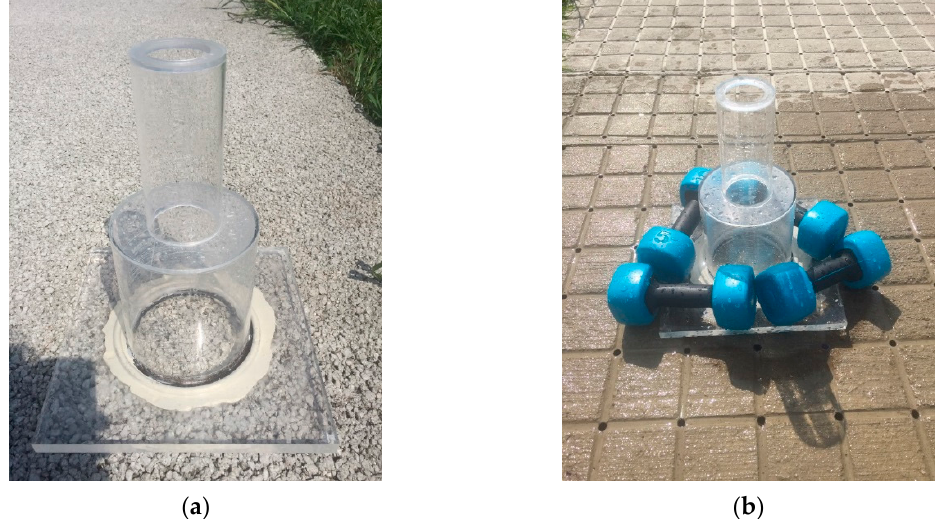
Figure 6. ( a ) The structure of the NCAT permeameter used in this study. ( b ) Usually, some weights were placed on the base to stabilize the instrument and to help secure the seal between the instrument and the test pavement.